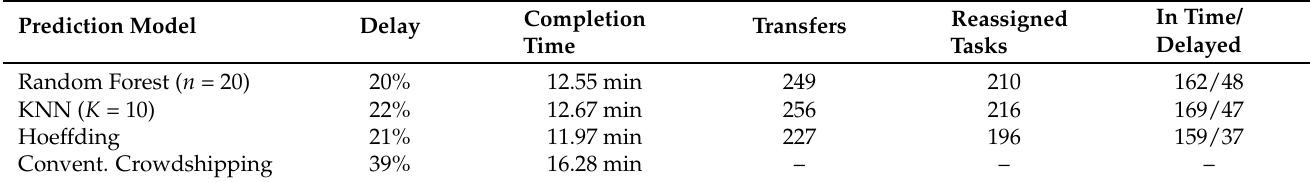
Table 3. Experimental results of collaborative parcel